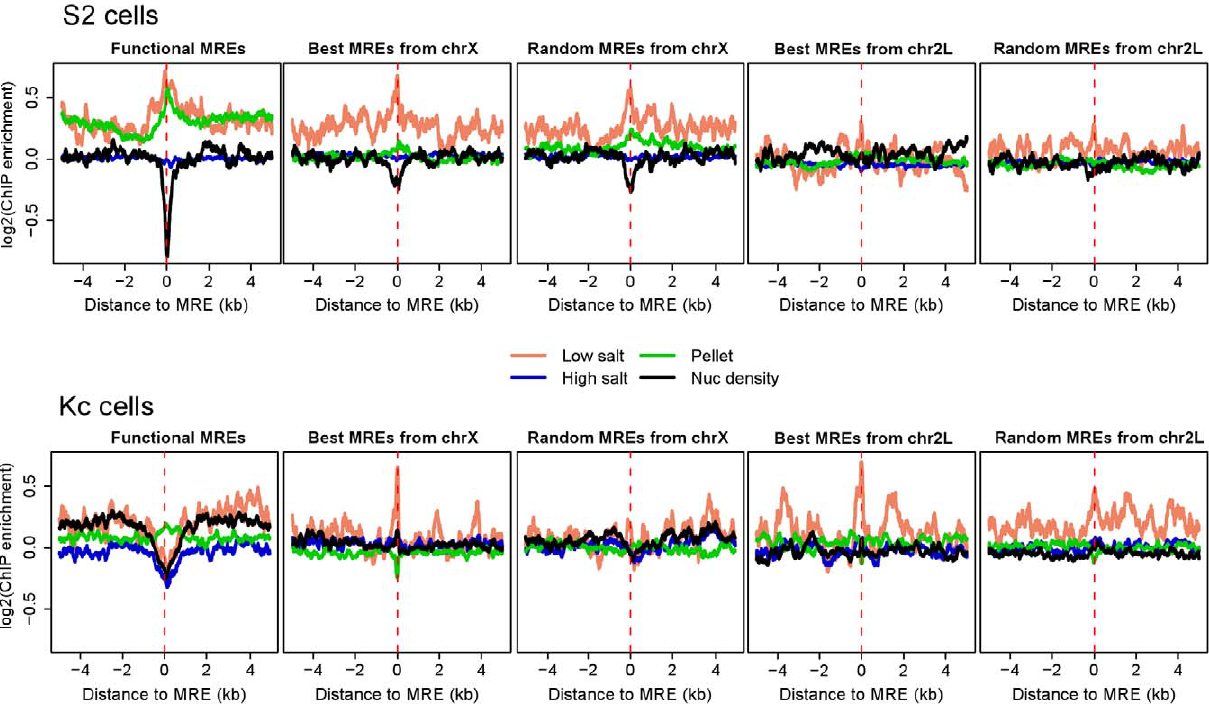
Figure 4. Increased lability of nucleosomes at chromatin entry sites correlates with MSL binding. Average enrichment profiles of chromatin properties around MREs are shown for S2 and Kc cells. Nucleosome density and successive salt extracted fractions of MNase-treated chromatin from S2 and Kc cells were described previously [28]. Profiled chromatin properties comprise nucleosome density (black) and successive salt extracted fractions of MNase-treated chromatin: low salt (pink, 80 mM NaCl), high salt (blue, 600 mM NaCl), and pellet (green, salt insoluble). The dashed red lines on each plot indicate the MRE centers. In male S2 cells, nucleosomes are more labile at the MREs on the X chromosome in general, and nucleosome density is especially low at functional MREs. The relative lability of nucleosomes on the X chromosome is not seen in female Kc cells, and the extent of nucleosome depletion at functional MREs is less pronounced. See also Figure S4.